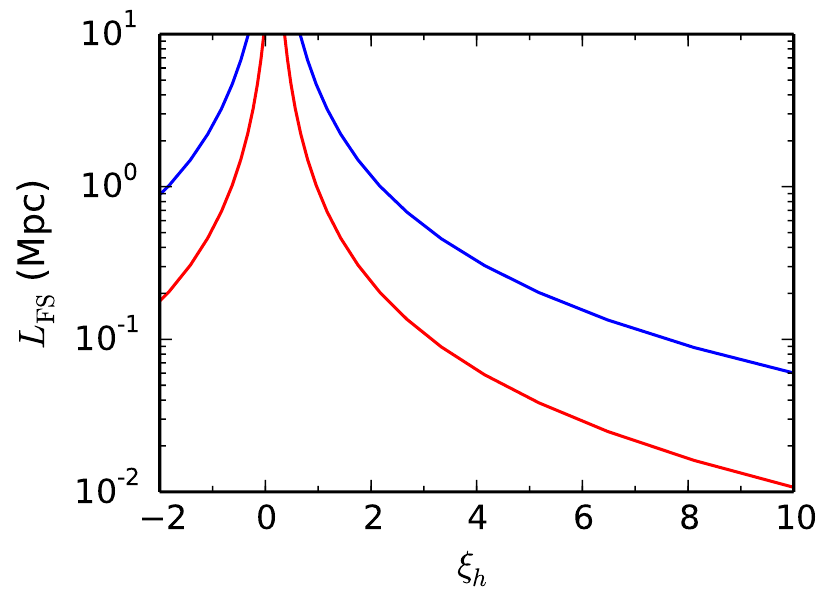
Figure 3 . L FS as a function of ξ h for the case that X is a scalar boson, taking ξ X = 0 (blue) and 0 . 1 (red). The result for ξ = 0 also applies to the case of massive Abelian gauge X